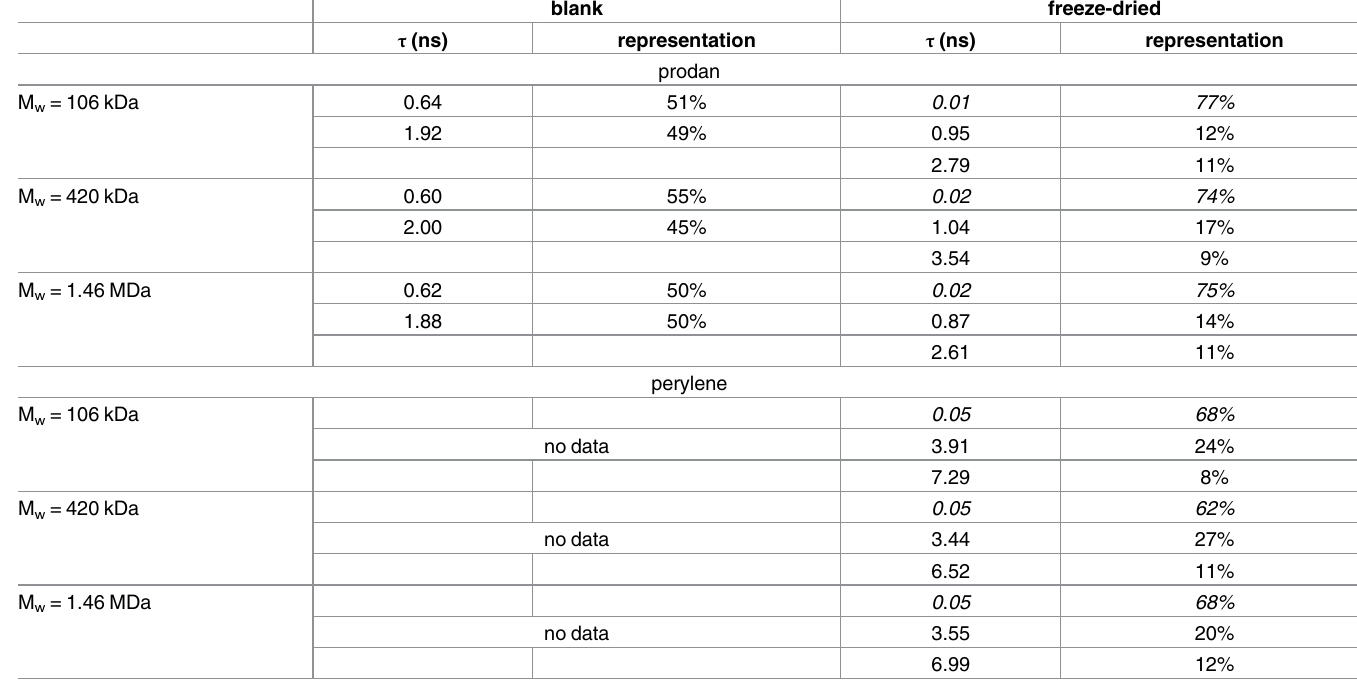
Table 5. Fluorescence lifetimes ( τ ) and relative representations for two different fluorescence probes and hyaluronan of different molecular weights (values in italics correspond to scatteredlight). blank